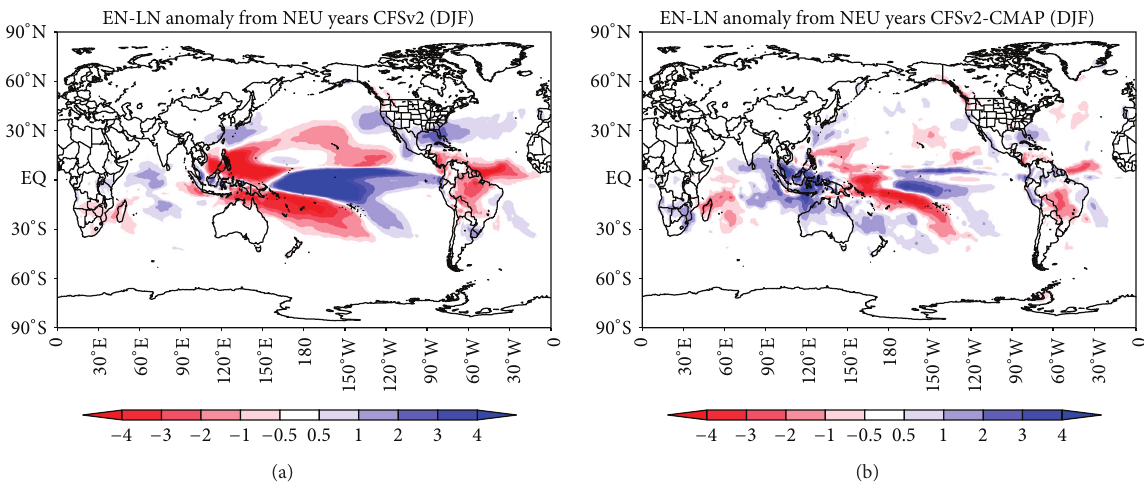
Figure 9: El Ni˜no minus La Ni˜na difference composites of anomalous total precipitation during DJF at 0-month lead time from (a) CFSv2 and (b) difference between CFSv2 minus CMAP. Differences are contoured every 1mm/day from 0.5